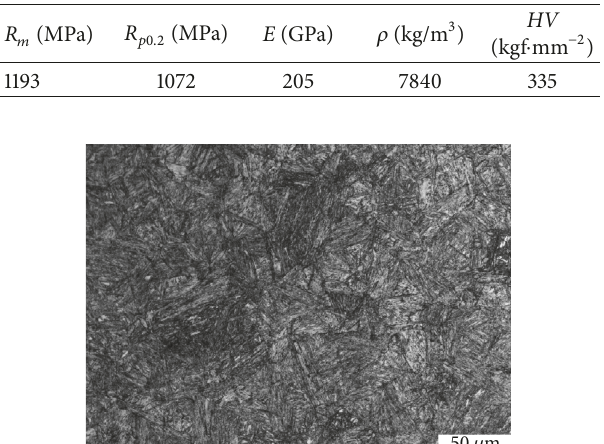
Table 1: Mechanical properties of KMN-I.